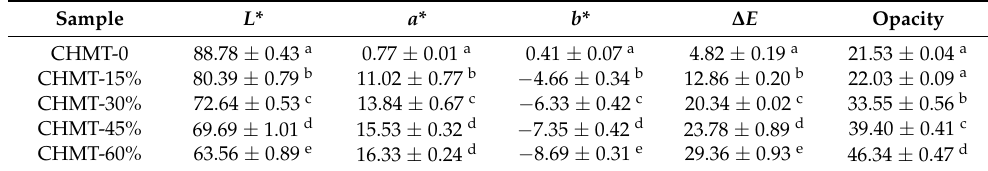
Table 3. Chroma and opacity of the double-layer antibacterial chromogenic materials.